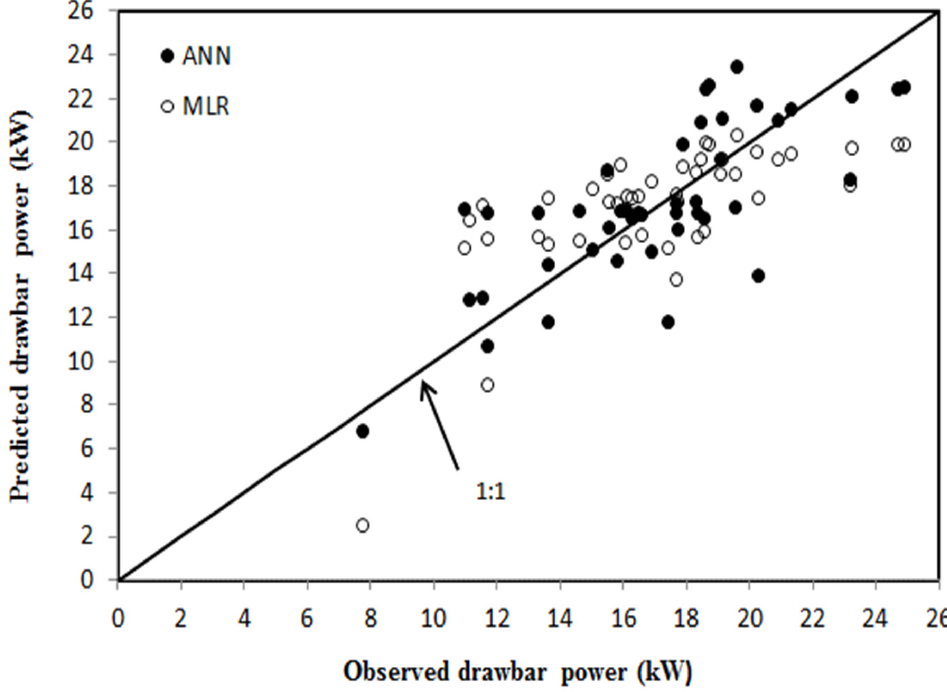
Figure 8. Correlation between the observed and predicted values for the drawbar power of the ANN and MLR models in the case of the testing dataset.